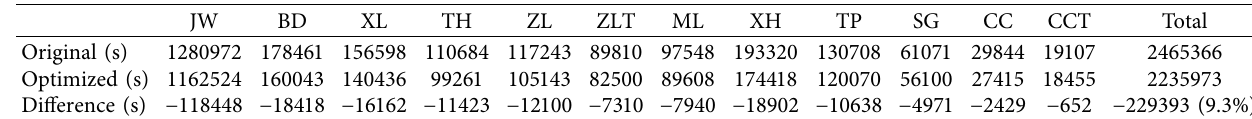
Figure 11: Optimized train timetable. Table 8: Changes of PWT at different